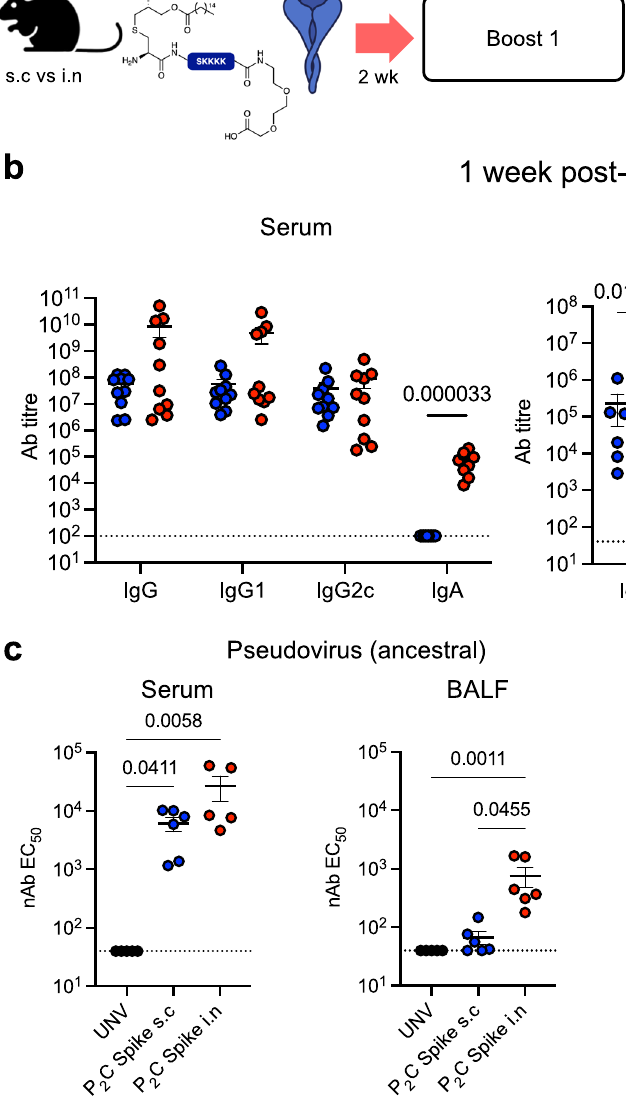
(nAb)titres(log 10 scale)intheserum( n =5or6animals)andBALF( n =6animals)of vaccinated mice were determined as the titre needed for 50% inhibition of SARS- CoV-2 Spike-expressing lentivirus in HEK293-ACE2 cells, and d 50% inhibition of SARS-CoV-2 infection in VeroE6 cells. Limits of detection are indicated by the dotted lines. Data points represent individual mice from two independent experi- ments,means+/ − SEMareshown.Statistics: p -valuesindicated,( b )Mann – Whitney (two-sided test), ( c , d ) Kruskal – Wallis test, Dunn ’ s multiple comparisons. Source data are provided as a Source Data fi